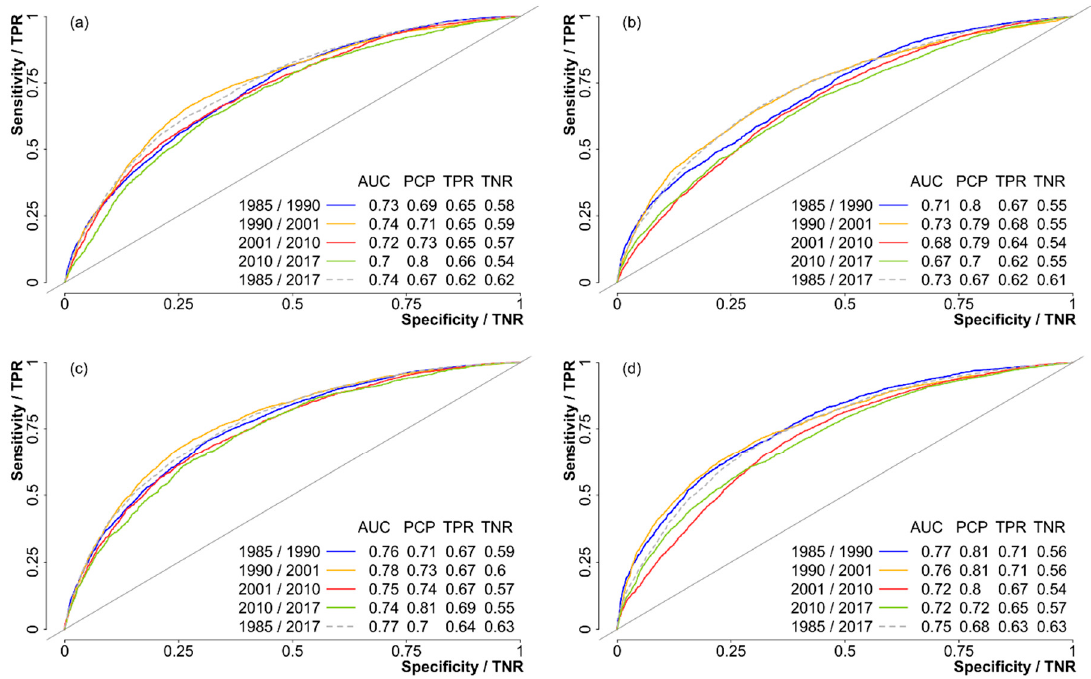
Figure 6. Receiver operating characteristic (ROC) curves corresponding to the binomial logistic regression analyses for ( a ) stable vegetated or woody vegetation loss and ( b ) stable unvegetated or woody vegetation gain without incorporation of relations among the independent variables, as well as for ( c ) stable vegetated or woody vegetation loss and ( d ) stable unvegetated or woody vegetation gain considering the variables’ relations. AUC—area under the curve, PCP—Percentage of Correct Predictions, TPR—True Positive Rates, TNR—True Negative Rates.